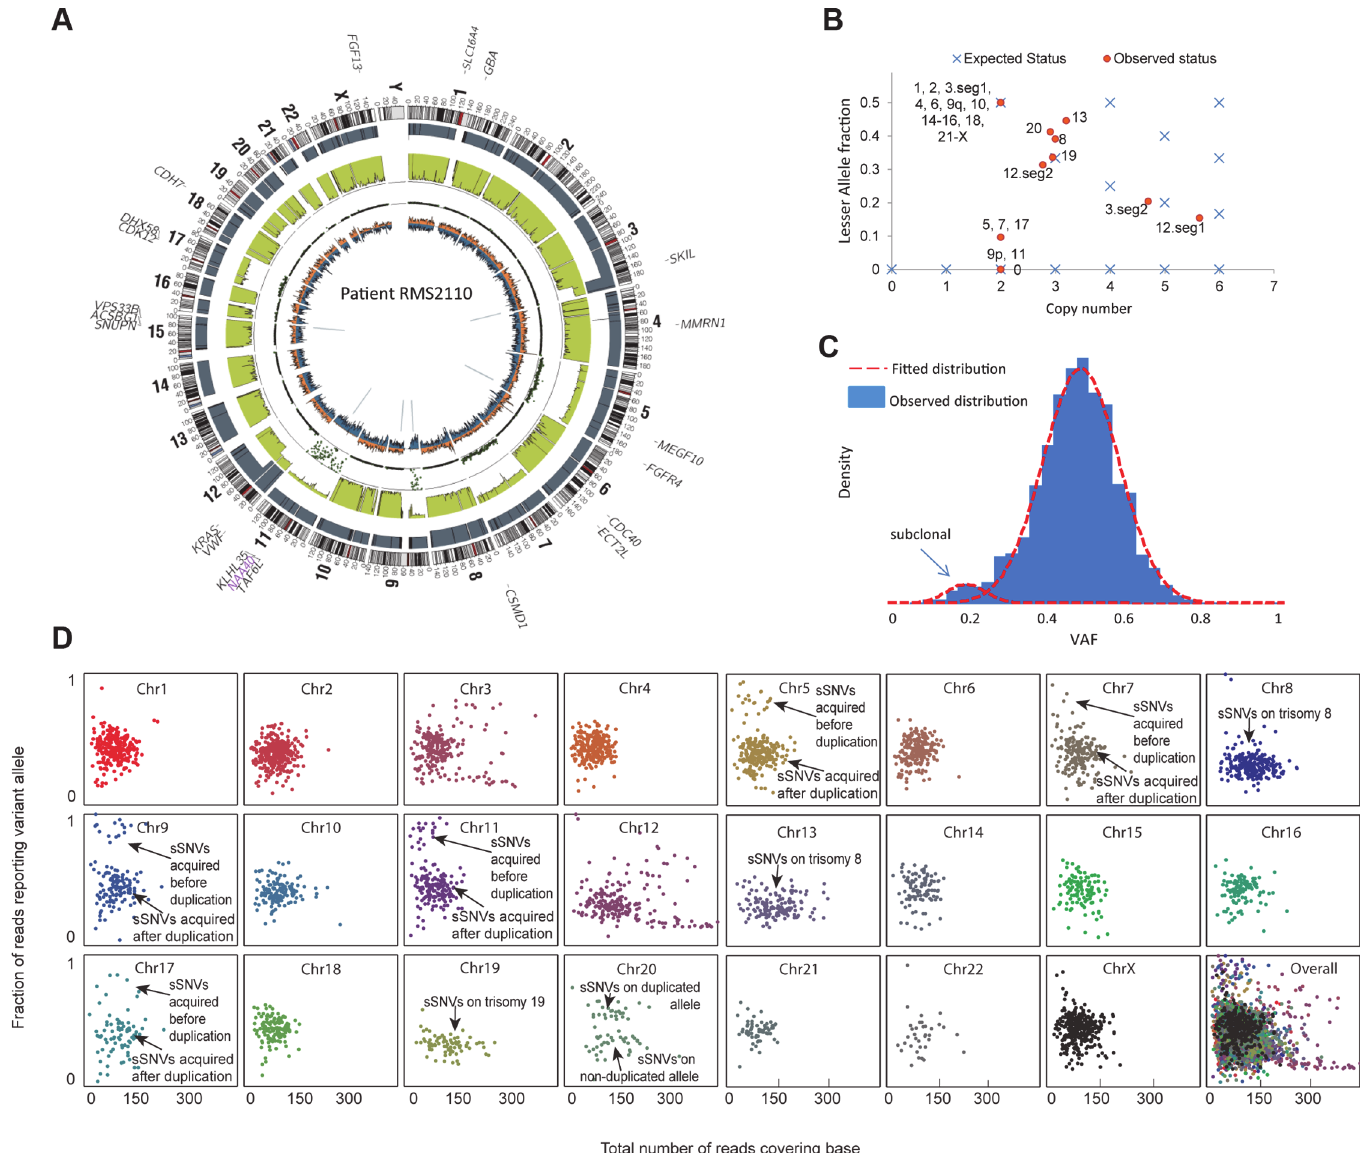
Fig 1. Inferring evolutionary history for a typical rhabdomyosarcoma sample RMS2110. (a) A circos plot of tumor genome RMS2110 (before normal cell contamination correction). Gene symbols indicate genes with nonsynonymous mutations. Tracks from outermost to innermost depict chromosome banding, copy number (the height of bars denotes copy number), lesser allele fraction (the height of green bars represents the fraction of lesser allele at each genomic location, valued 0 * 0.5), loss of heterogeneity status (each dot represents the probability of loss of heterozygosity for the adjacent segment), intensity of heterozygous (orange bar) and homozygous single nucleotide variants (blue bar), junctions or chromosomal rearrangement (grey lines). (b) Discrepancy between expected and observed status of allelic copy number suggests the existence of subclone(s) in tumor. Red dots denote chromosome segments, whereas blue crosses denote statuses of copy number and lesser allele fraction that leads to an integer allelic copy number. If there are tumor subclones with copy number status different from the major clone, the red dots will deviate from the blue crosses. (c) Observed VAF distribution of somatic mutations on chromosomes without aneuploidy. The normal-mixture like distribution suggest the existence of a minor subclone with VAF < 0.5. (d) A scatter plot showing coverage (horizontal axis) and VAF (vertical axis) for somatic mutations (sSNV) on each